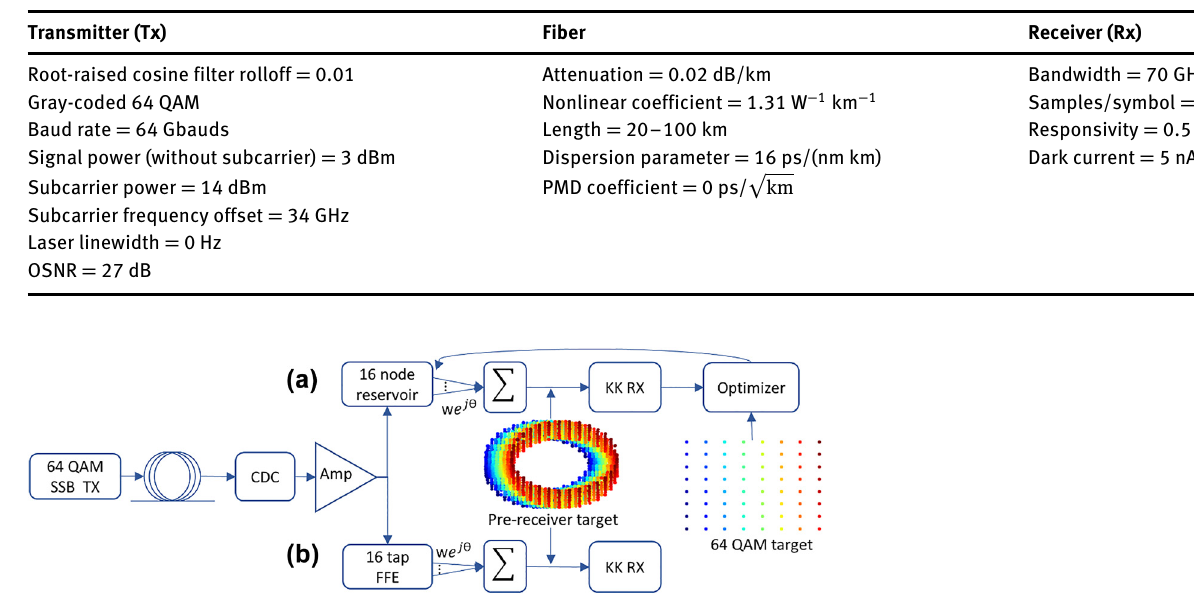
Table 1: System parameters.